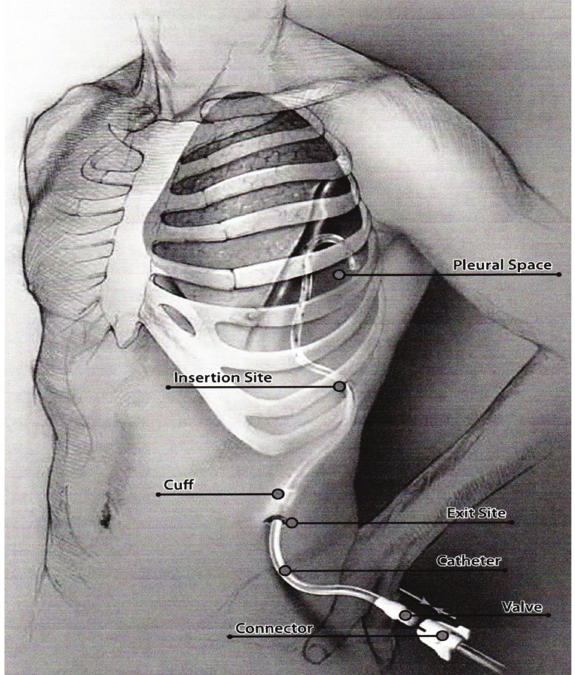
Figure 3: A pictorial representation of a chronic indwelling catheter (Aspira) which is tunneled beneath the skin to enter the pleural cavity at a distant site. This assembly prevents introduction of infection in the pleural cavity and can provide long term drainage of infected pleural e ff usion.